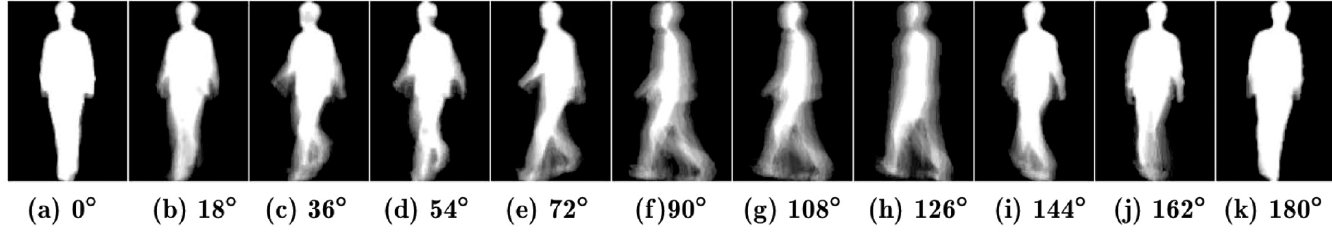
Fig 6. Examples of the GEI features under different views in the CASIA dataset